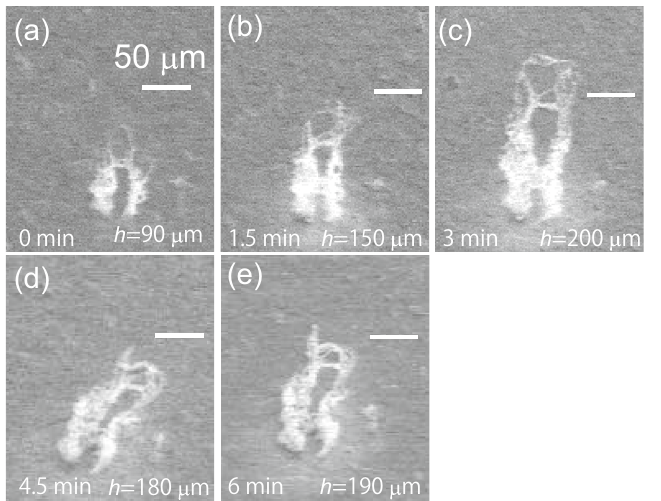
Figure 10. Evolution of an NTB by the co-deposition experiments ( a ) before co-deposition experiments, after (b ) 1.5-min-irradiation, ( c ) 3.0-min-irradiation, ( d ) 4.5-min-irradiation, and ( e ) 6-min-irradiation.